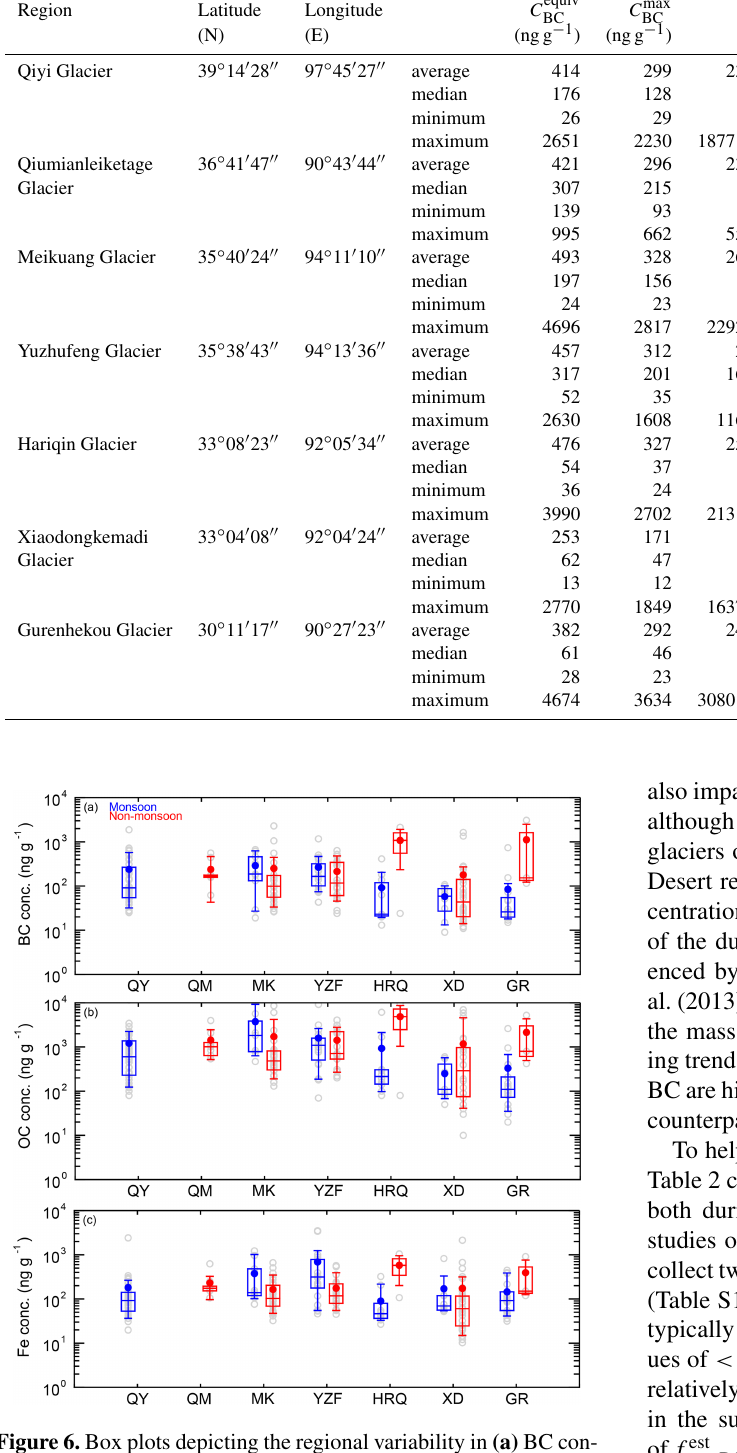
Table 1. Statistics of the ILAPs in each glacier measured using an ISSW spectrophotometer associated with the chemical analysis. Region Latitude